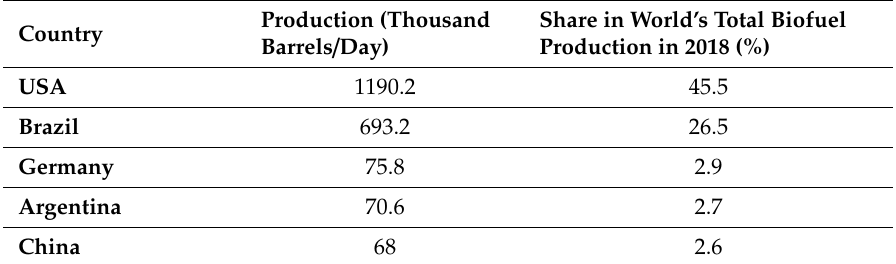
Table 13. The amount of biofuel production and the share in global production of biofuels in 2018 of the top five countries